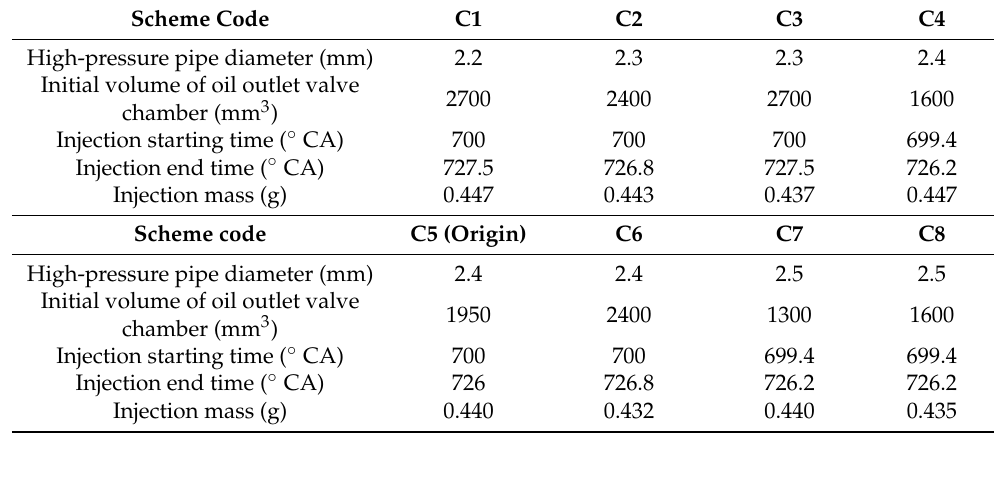
Figure 29. Effect of diameters of high-pressure oil pipe and volume of fuel outlet valve on mass, pressure and SMD. Table 5. Pre-selection scheme of high-pressure volume.